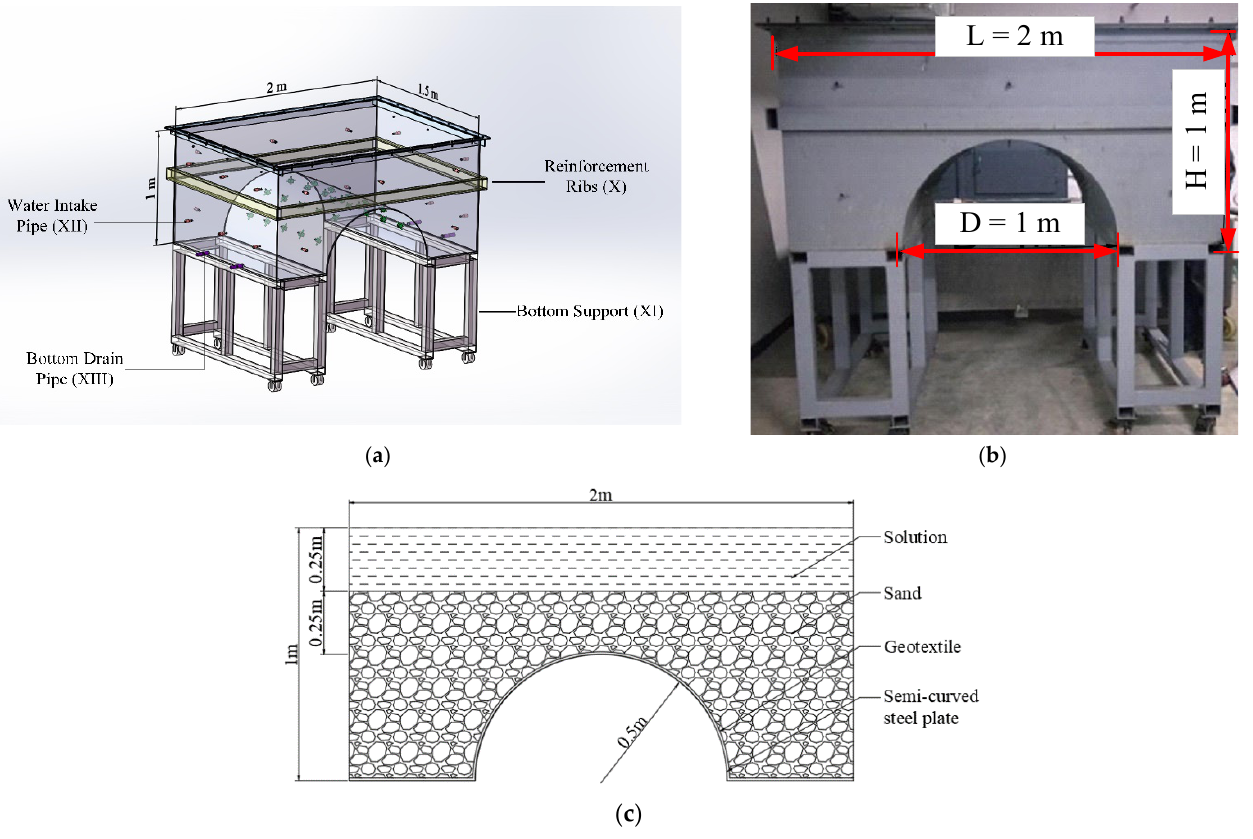
Figure 3. The testing chamber and the cross-section of tunnel. ( a ) Schematic diagram of the testing chamber. ( b ) Physical photograph of the testing chamber. ( c ) Sketch of the cross-section of